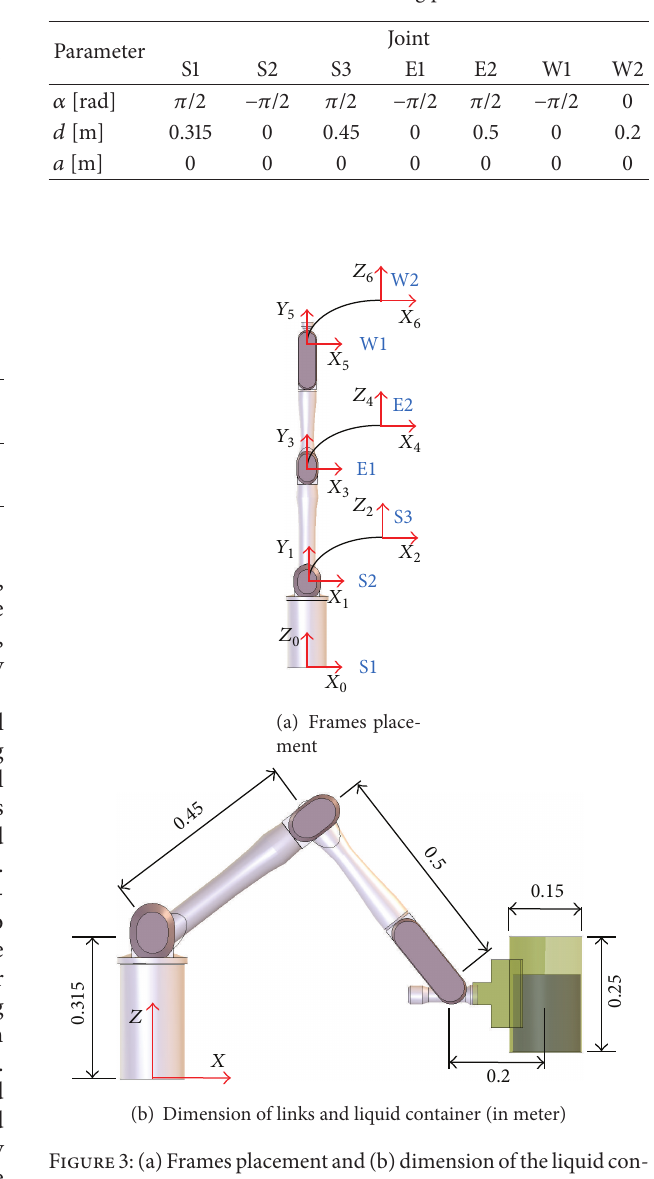
Table 2: Denavit-Hartenberg parameters.